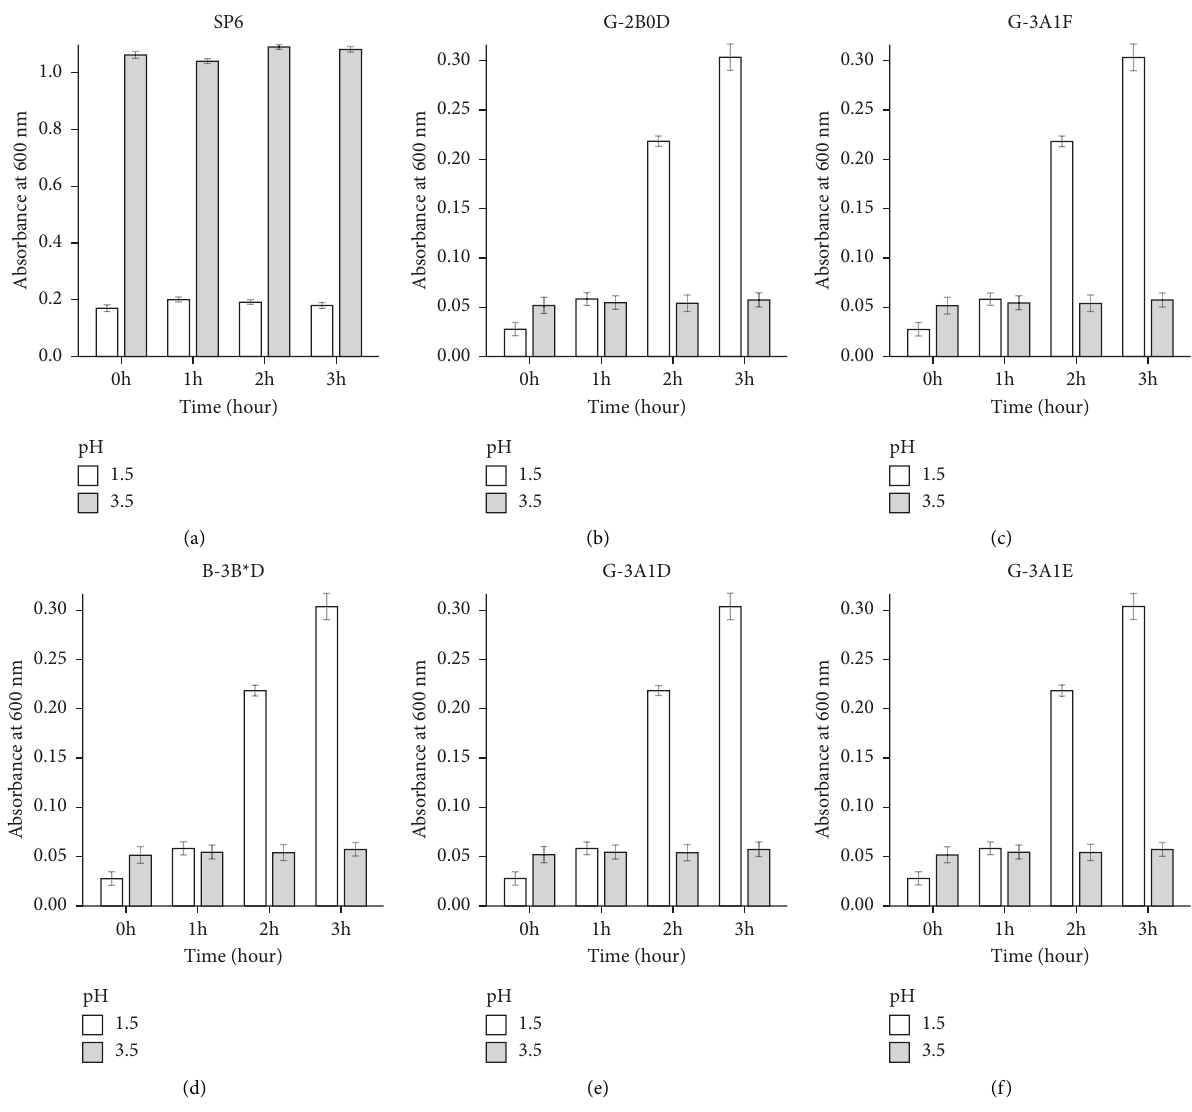
Figure 1: Growth rates of Salmonella typhimurium strains (a) SP6, (b) G-2B0D, (c) G-3A1F and Salmonella enteritidis strains (d) B–3B (e) G-3A1D, and (f) G-3A1E under acidic conditions (pH 1.5 and pH 3.5). The bars represent the standard deviation of the mean. The graph is generated in